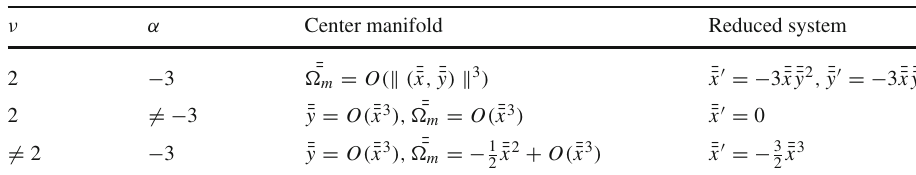
Table 6 A summary for the critical point C